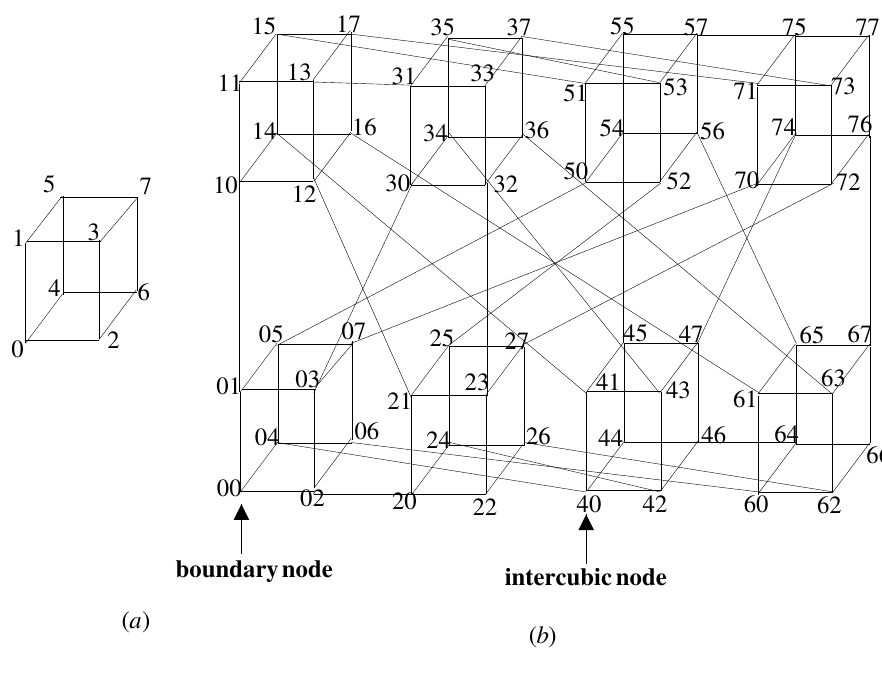
Figure 1. FCCNs ( a ) H 1 ( b ) H 2 with 00,11, . . . ,77 as boundary